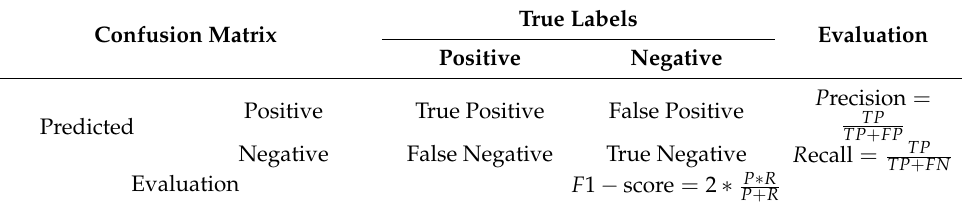
Table 3. Confusion matrix and evaluation index calculated accordingly.